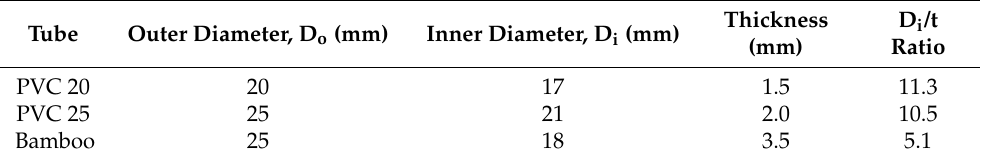
Table 1. Physical properties of PVC and Bamboo tubes.